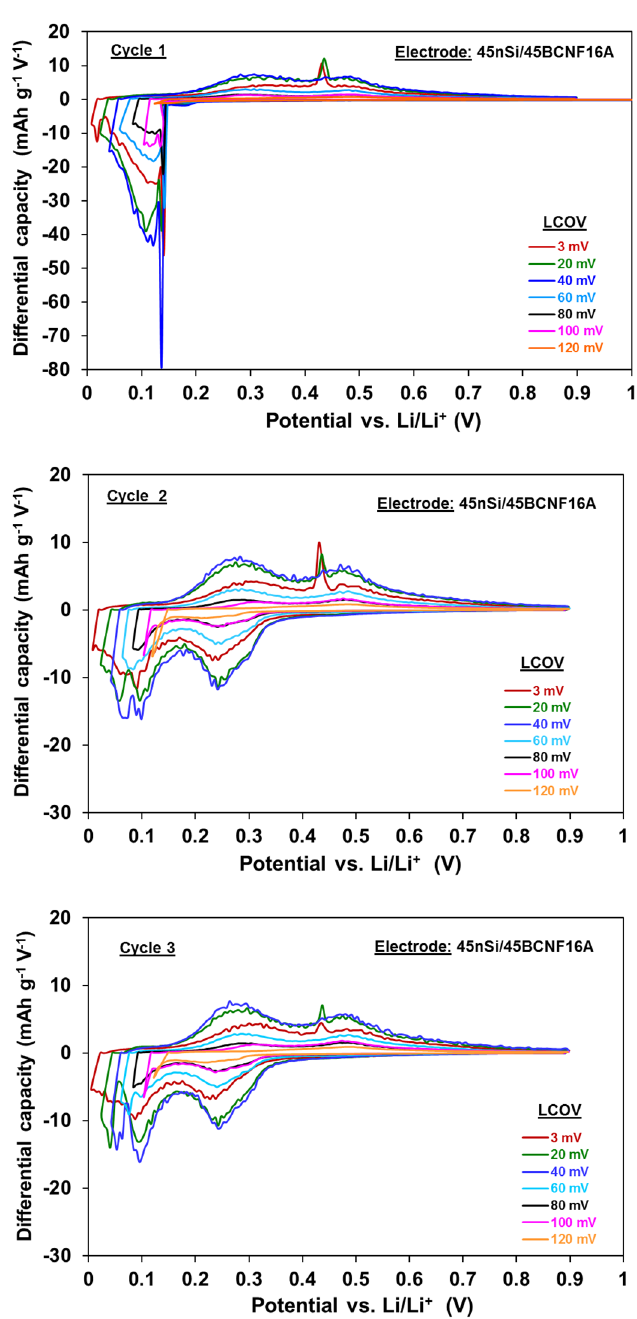
Figure 5. Di ff erential charge / discharge capacity against potential vs. Li / Li + plots from the galvanostatic Figure 5. Differential charge/discharge capacity against potential vs. Li/Li + plots from the galvanos- cycling at 100 mA g − 1 of 45nSi / 45BCNF16A electrode for cycles 1st, 2nd and 3rd, in the 0.9 V– X mV tatic cycling at 100 mA g − 1 of 45nSi/45BCNF16A electrode for cycles 1 st , 2 nd and 3 rd , in the 0.9 V– X mV potential range. X = lower cuto ff voltage potential range. X = lower cutoff voltage (LCOV).